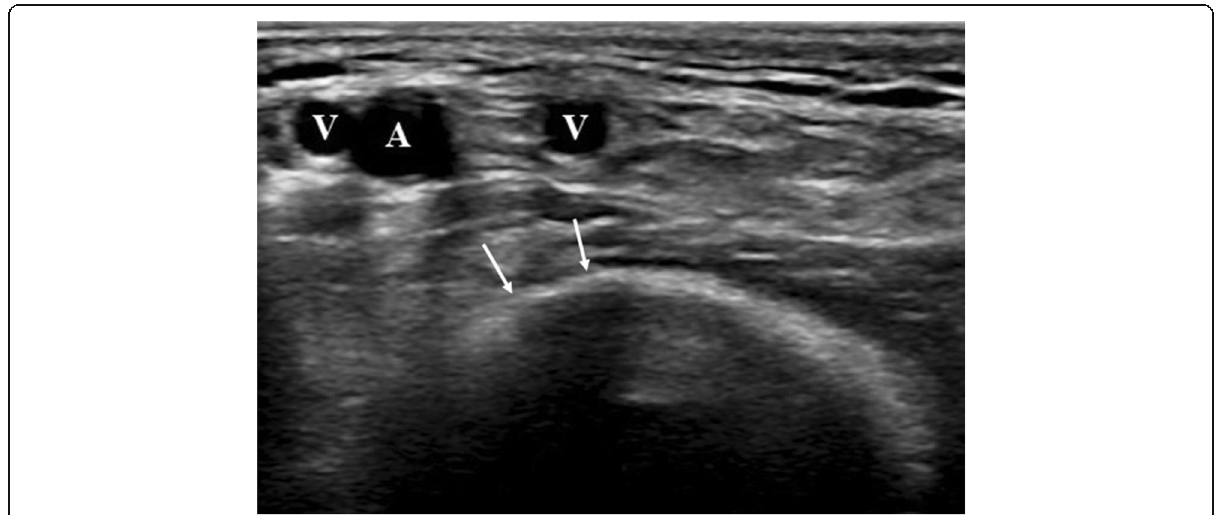
Fig. 1 Transversal ultrasound picture of the A. brachialis (A) in the cubital fossa. The distal humerus (white arrows) forms an abutment, which helps for manual compressions. Two brachial veins (V) often accompany the distal A. brachialis